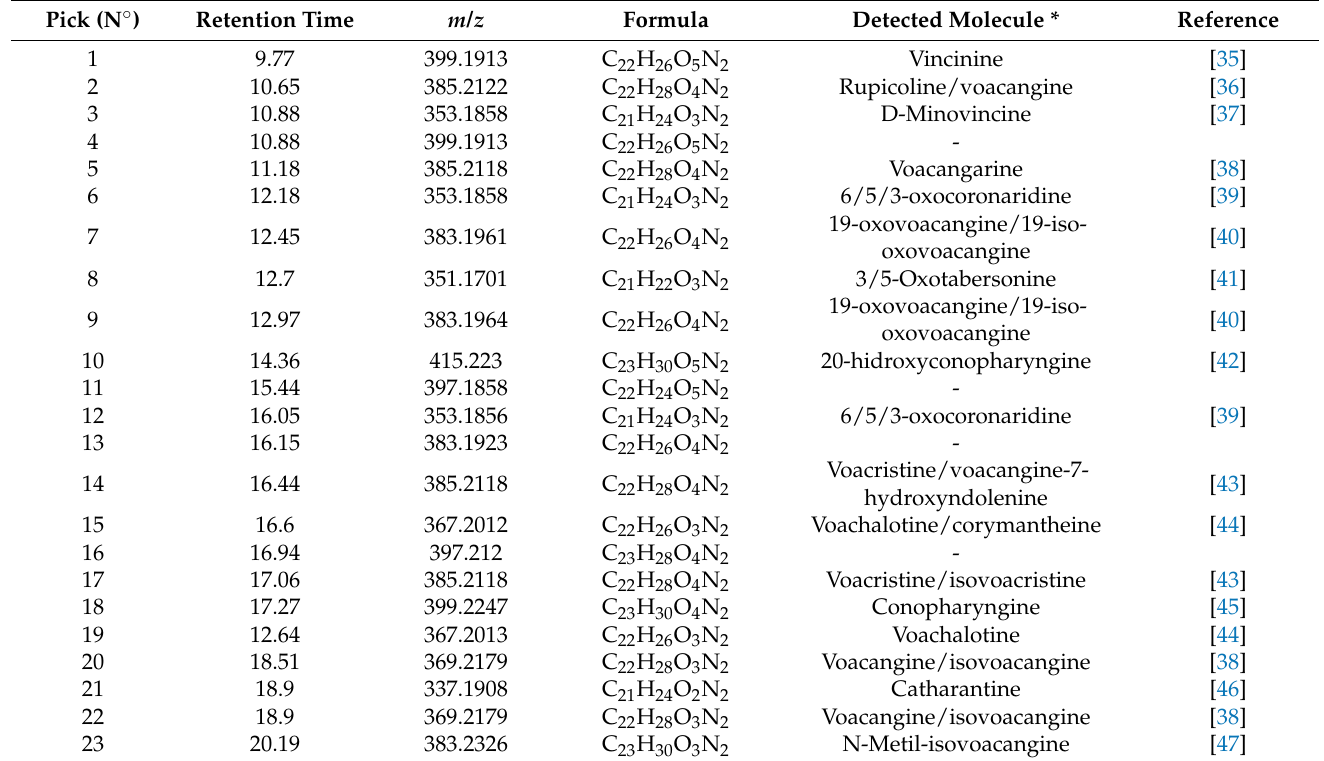
Figure 1. Molecular structure of indole alkaloids presents in Tabernaemontana cymosa Jacq. Table 1. Identification of indole alkaloid type molecules present in the ethanolic extract of T. cymosa seeds.